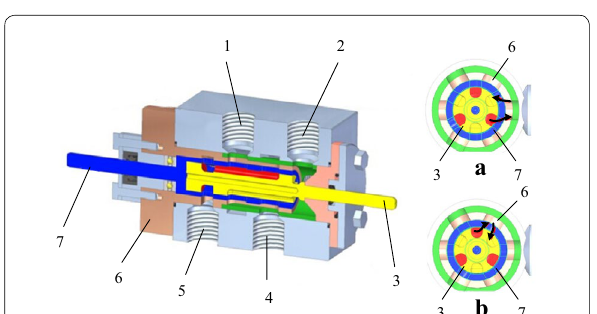
Figure 15 New type of 4-way high-speed rotary-valve: a leakage from rotor to stator; b leakage from control shaft to rotor. 1. Oil port B; 2. Low pressure oil port; 3. Control shaft; 4. Oil port A; 5. High pressure oil port; 6. Stator; 7.